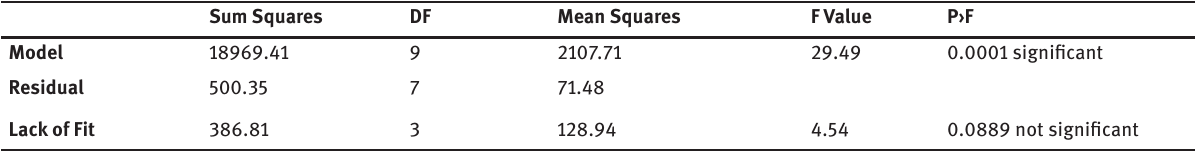
Table 5: Analysis of varience (ANOVA) for fitted quadratic polynomial model of polyphenol amount in white tea. Sum Squares